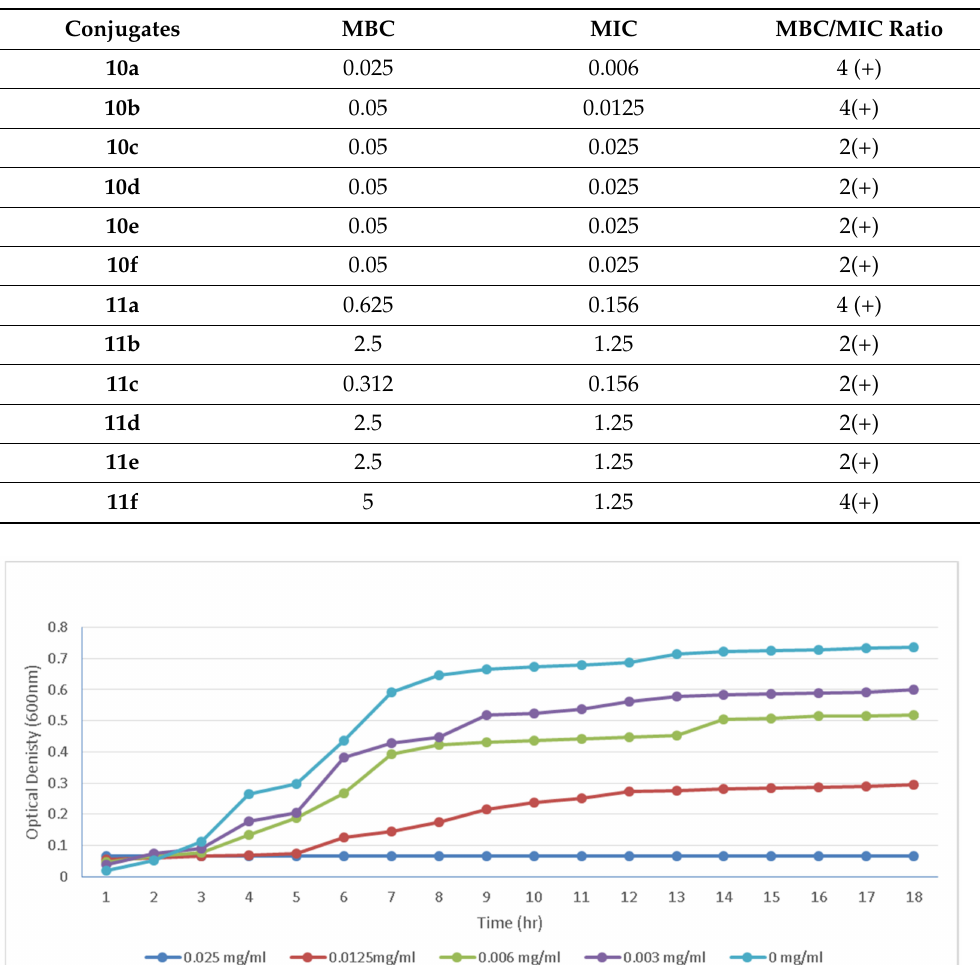
Table 6. MIC, MBC and MBC/MIC ratio for 10a – f and 11a – f against MRSA.